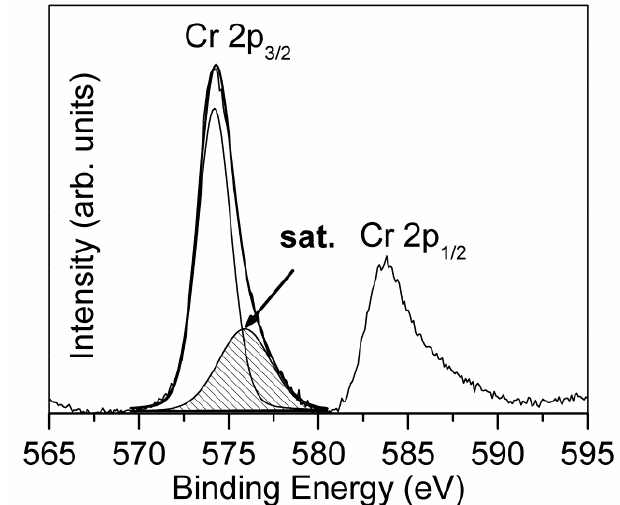
Figure 8. XPS depth profile of the Ti/TiN composite coating. The average sputtering rate was equal to 0.3 nm·min −1 [19].